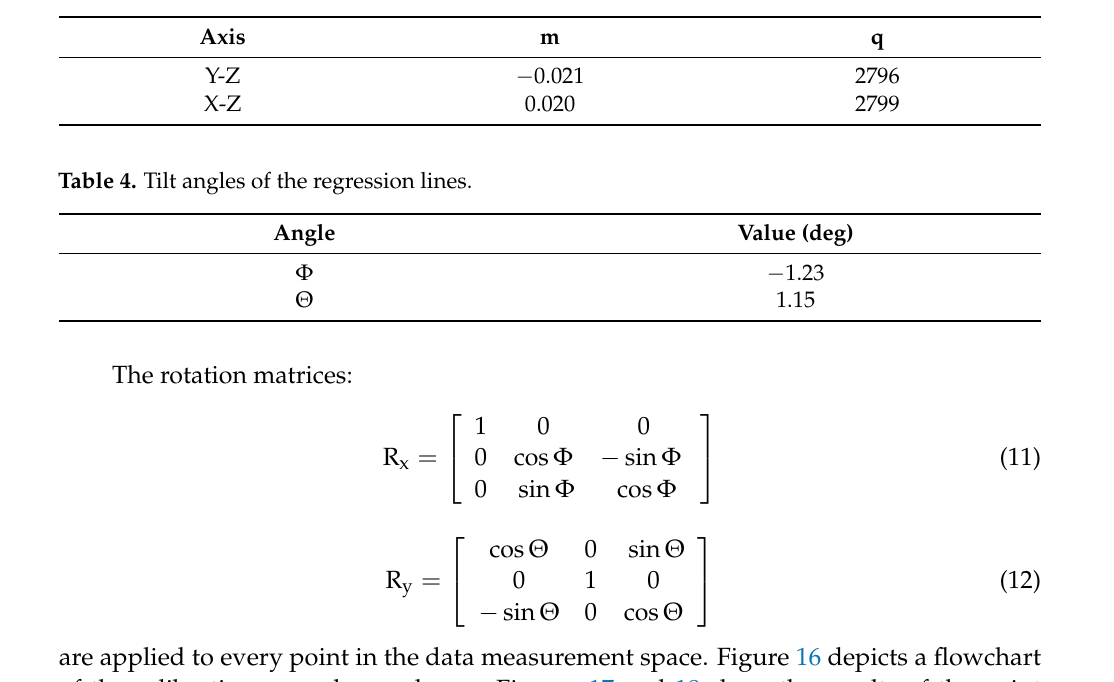
Figure 15. Regression lines for yz- and xz-planes. Table 3. Parameters of the regression lines in the xz- and yz-planes.